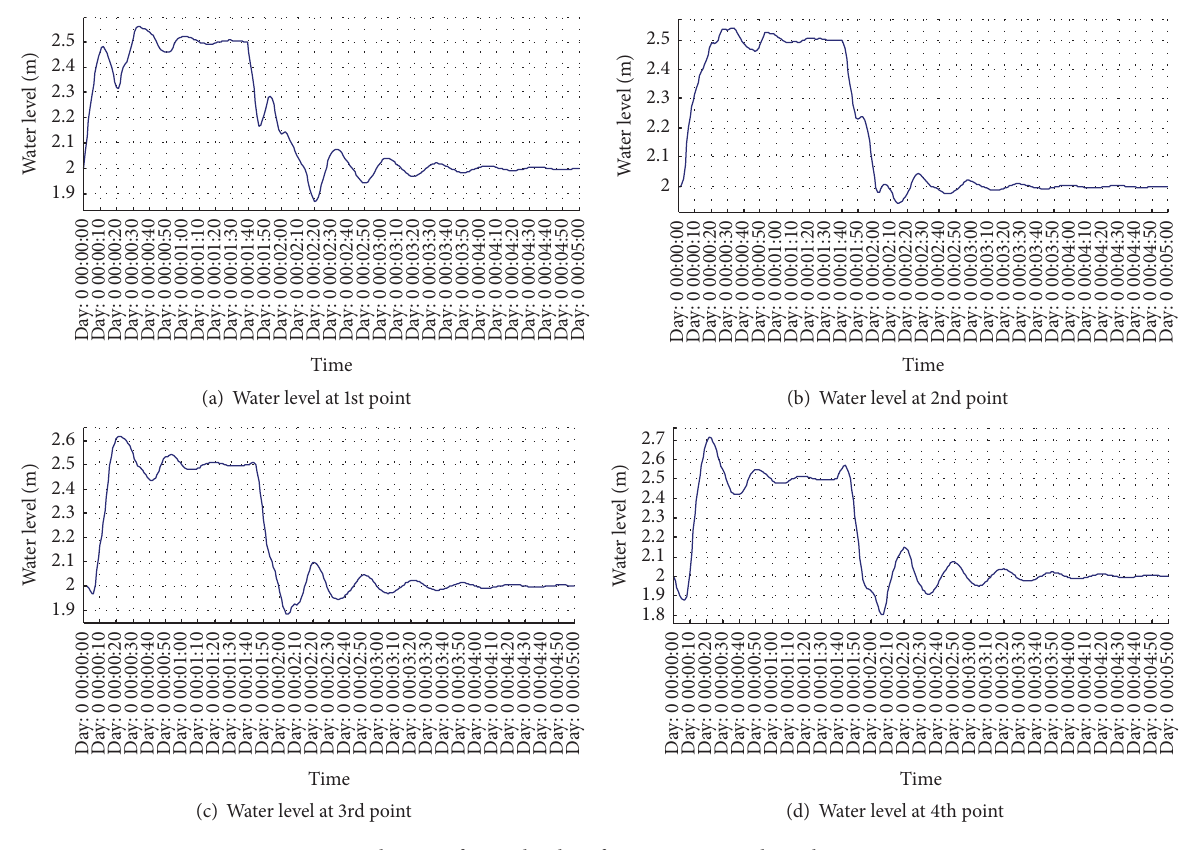
Figure 8: Evolutions of water levels at four points in pool 1 with 𝑁 = 𝑀 = 10 . Table 1: Geometric parameters of one single-pool canal.